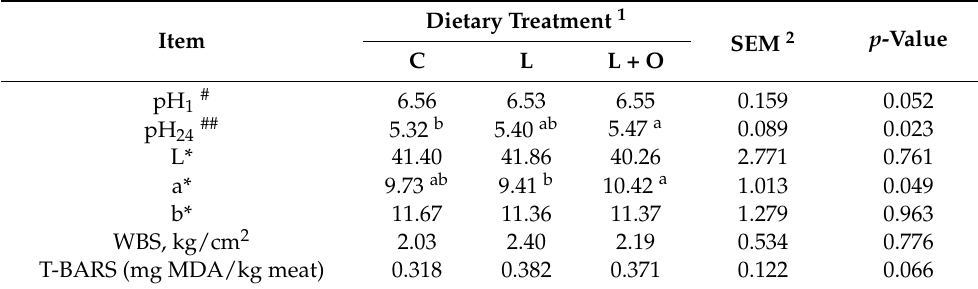
Table 7. Meat characteristics from Longissimus lumborum muscle